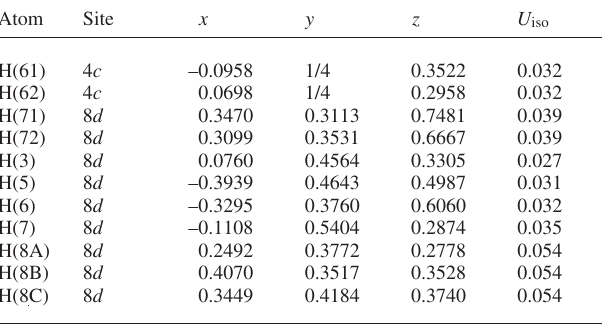
Table 2. Atomic coordinates and displacement parameters (in Å 2 )